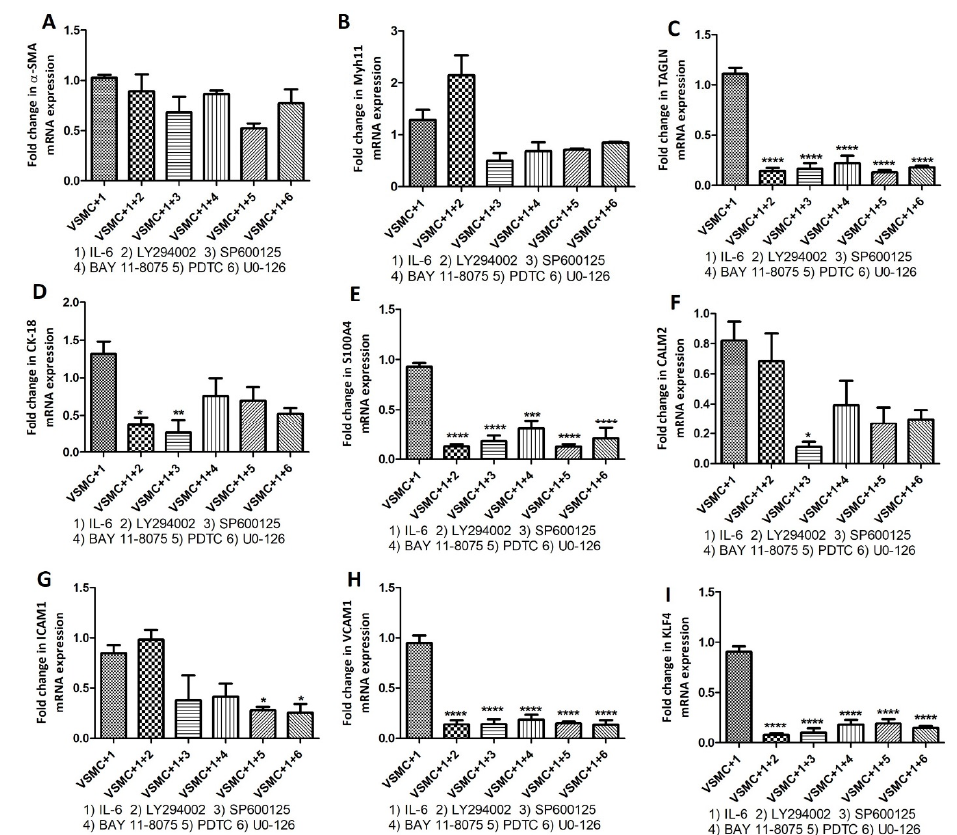
Figure 7. RT-qPCR to investigate the effect of IL-6 on VSMCs phenotype markers after inhibiting cytoplasmic kinases. RT-PCR data for alpha-smooth muscle actin ( α -SMA; panel A ), Myosin Heavy Chain 11 smooth muscle (Myh11; panel B ), transgelin (TAGLN; panel C ), cytokeratin 18 (CK-18; panel D ), S100 protein A4 (S100A4; panel E ), calmodulin 2 (CALM2; panel F ), Intercellular Adhesion Molecule 1 (ICAM1; panel G ), Vascular Cell Adhesion Molecule 1 (VCAM1; panel H ), Krüppel-like factor 4 (KLF4; panel I ). α -SMA, TAGLN, and Myh11 (markers for contractile vascular smooth muscle cells (VSMCs)); CK-18, S100A4, CALM2, and ICAM1 (markers for proliferative VSMCs); and KLF4 (marker for de-differentiated VSMCs). Interleukin (IL)-6, LY294002 (PI3K inhibitor), SP600125 (JNK inhibitor), BAY 118075 (NF- κ B inhibitor), PDTC (NF- κ B inhibitor), and UO-126 (ERK inhibitor). All * p < 0.05, ** p < 0.01, *** p < 0.001, and **** p <